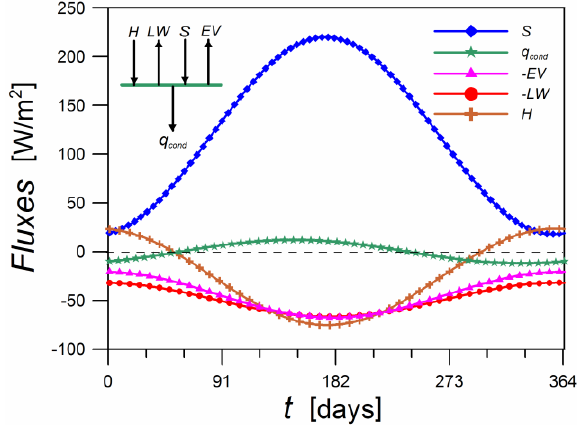
Figure 4. Annual temperature courses: air, ground surface, the sky and the gradient of the ground temperature on its surface.